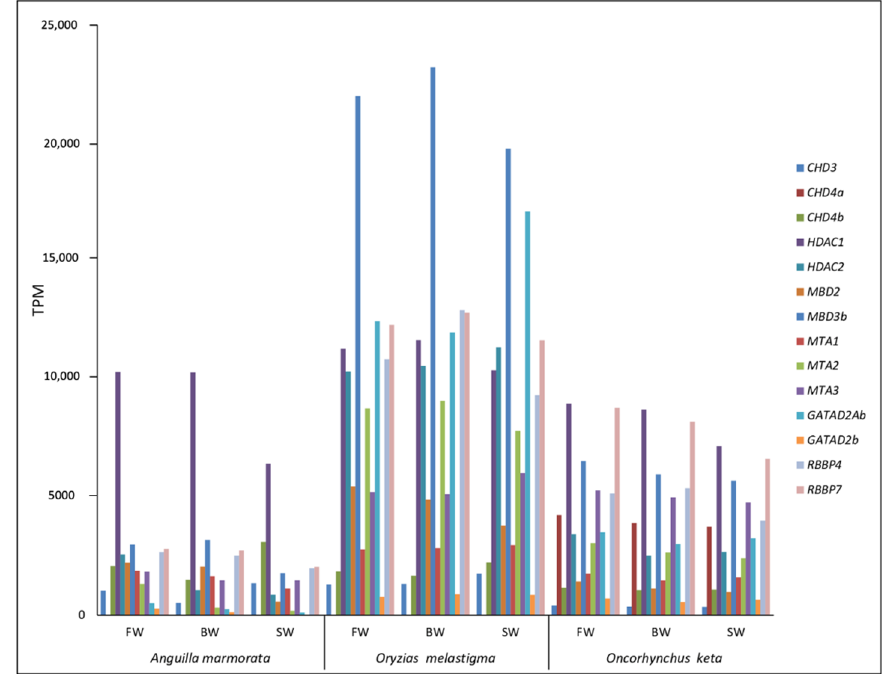
Figure 4. Transcriptional activity of NuRD complex genes in Anguilla marmorata, Oryzias melastigma , and Oncorhynchus keta gill transcriptomes. FW: freshwater; BW: brackish water; SW: salt water.